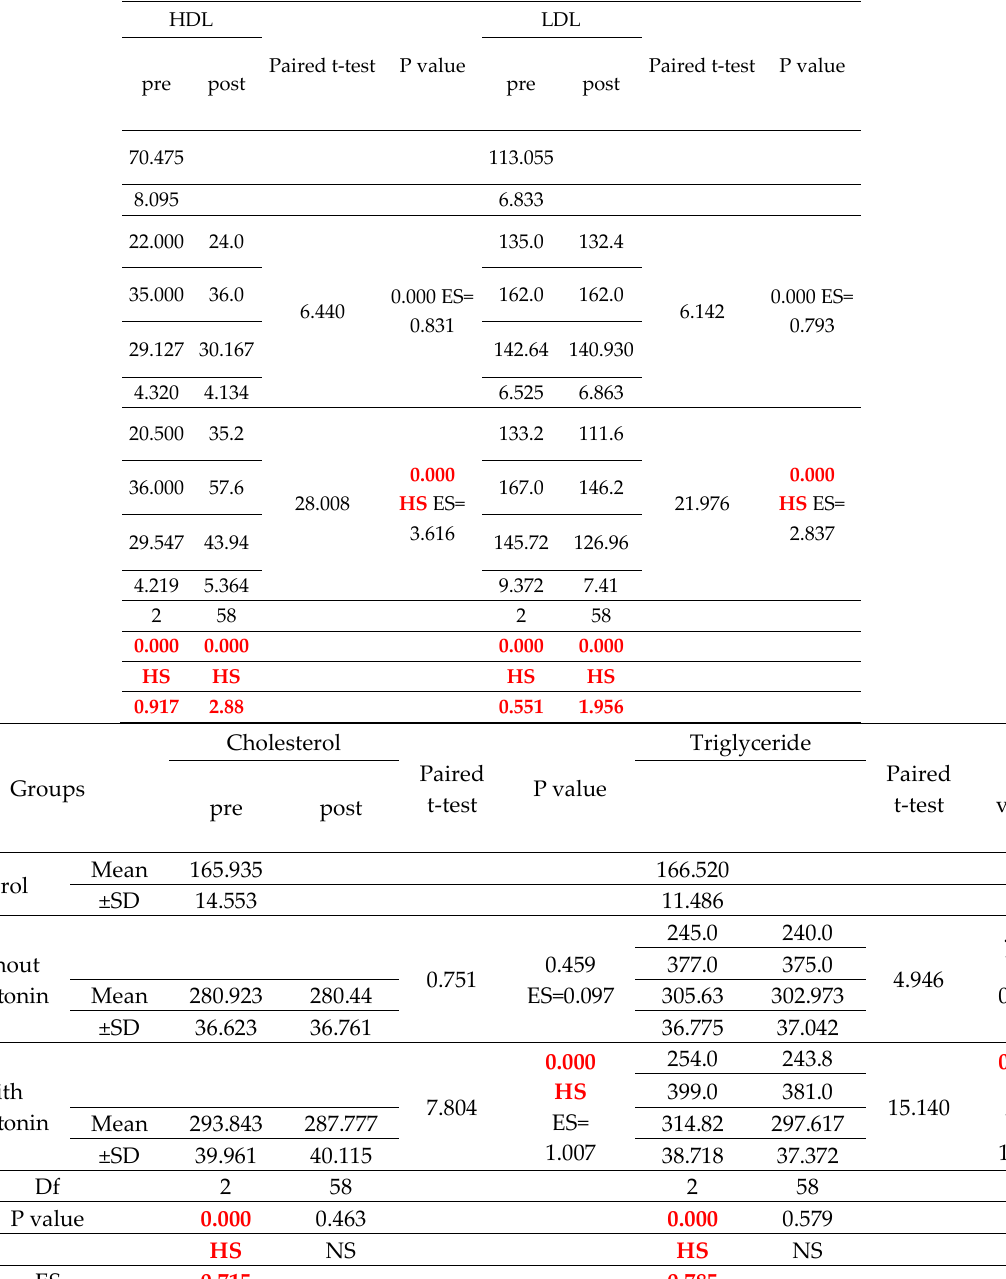
Table 4: Statistical test of lipid profile among groups and visits (Inter and Intra comparisons) using One Way ANOVA, Independent and dependent sample